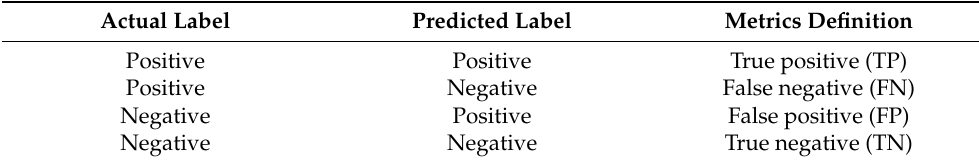
Table 4. Definition of the terms used to calculate evaluation metrics. Actual